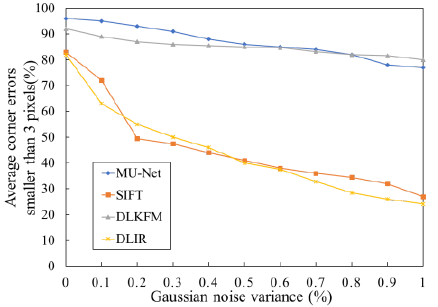
Figure 9. Percentage of images with ACE smaller than 3 pixels versus various Gaussian